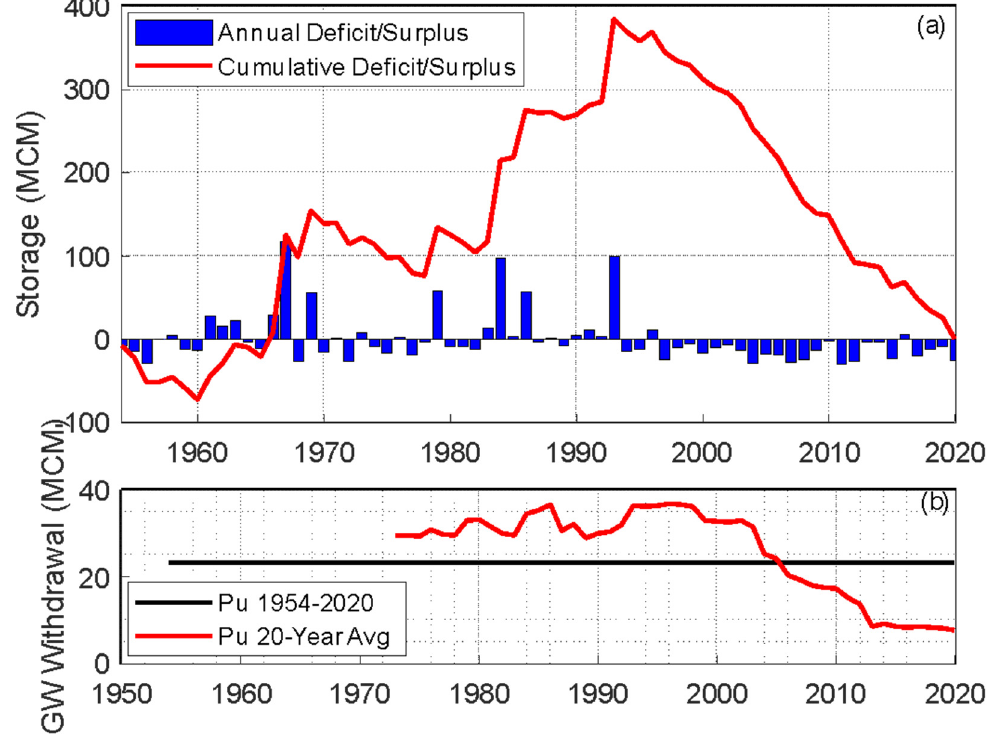
Figure 5. ( a ) Estimated annual and cumulative storage with annual groundwater withdrawal rate that yields an average of zero storage during the period 1954–2020. ( b ) Estimated sustainable groundwater withdrawal (Pu) using a 20-year moving average interval (red) and the 1954–2020 du- ration.